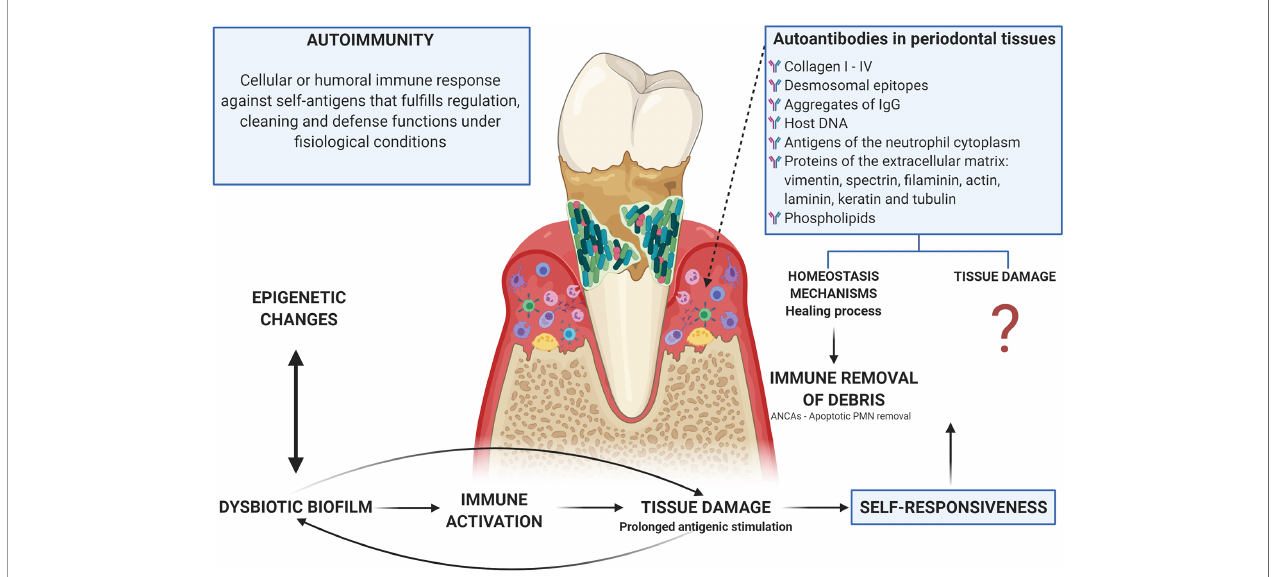
FIGURE 4 | Autoimmunity in periodontitis: tissue damage related or homeostasis mechanisms? There is an evident relationship between the dysbiotic microbiota, the activation of in fl ammatory mechanisms, and the tissue damage observed in periodontitis, which leads to prolonged antigenic stimulation due to tissue breakdown with the release of matrix proteins. In turn, microorganisms use these products of tissue damage as a nutritional source. This persistence of both self and exogenous (microbial) antigens leads to the occurrence of autoimmunity, which can be understood as a mechanism by which debris generated by tissue damage are removed through the generation of autoantibodies (including ANCAs as a mechanism for the cleaning of apoptotic bodies after the activation of phagocytic cells) or as a damage machinery, although the evidence for the participation of autoimmune mechanisms in the tissue damage observed in periodontitis is poor and lacking analysis. Additionally, microorganisms and their products can alter the activity of epigenetic enzymes at the same time that these epigenetic changes can induce dysbiosis, thus epigenetics being a determining factor in the occurrence of autoimmunity due to a direct relationship with the breakdown of immunological